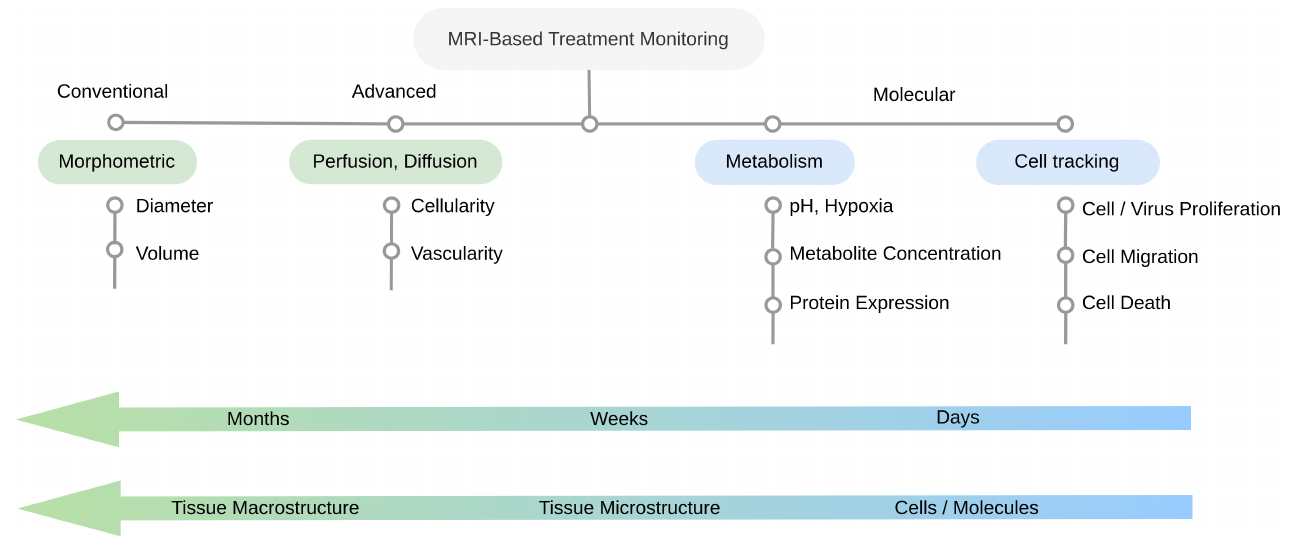
Figure 2. MRI-based approaches for immunotherapy response monitoring. Conventional MRI may detect morphometric changes, which appear at a relatively late stage (months after treatment initia- tion). Advanced (perfusion and diffusion) MRI enables the detection of cellularity and vascularity- related changes, which appear after weeks or months, without direct specificity to the immune processes. Molecular MRI enables specific cell or virus tracking or the imaging of metabolism, thus providing the earliest time window for immunotherapy response